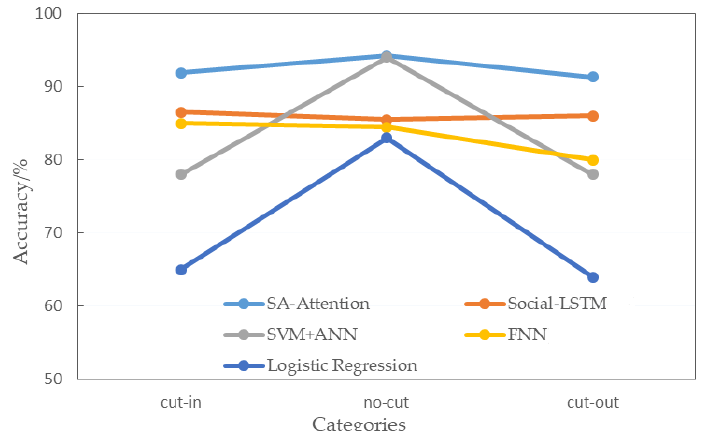
Figure 12. Comparison of prediction accuracy of different methods.